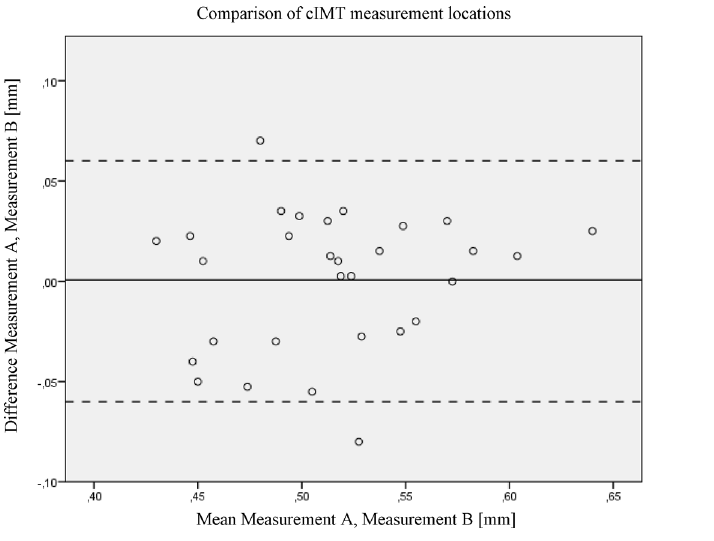
Fig 2. Bland-Altman analysis of measurement A and